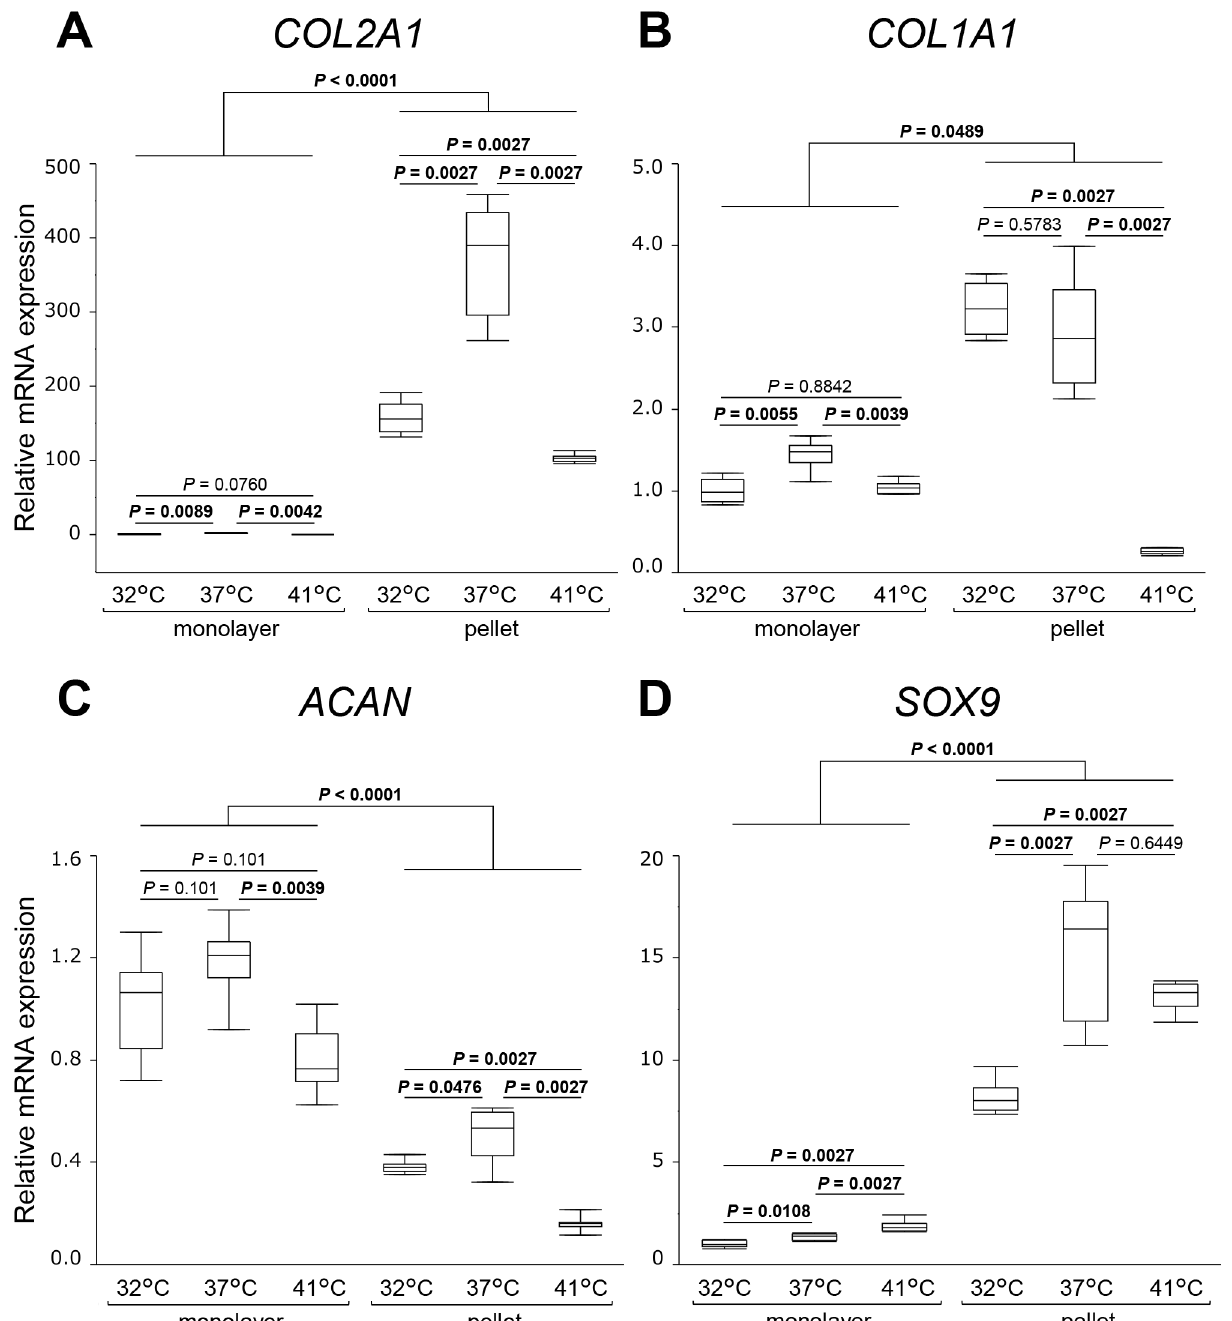
Fig 4. Chondrocyte phenotype and extracellular matrix-related gene expression. COL2A1 (A), COL1A1 (B), ACAN (C), and SOX9 (D) relative mRNA expression was measured at three different culture temperatures in monolayer and pellet culture systems. Values are expressed as median and interquartile range. n = 8 dishes or pellets/group. Significantly different values ( P < 0.05) are written in bold.